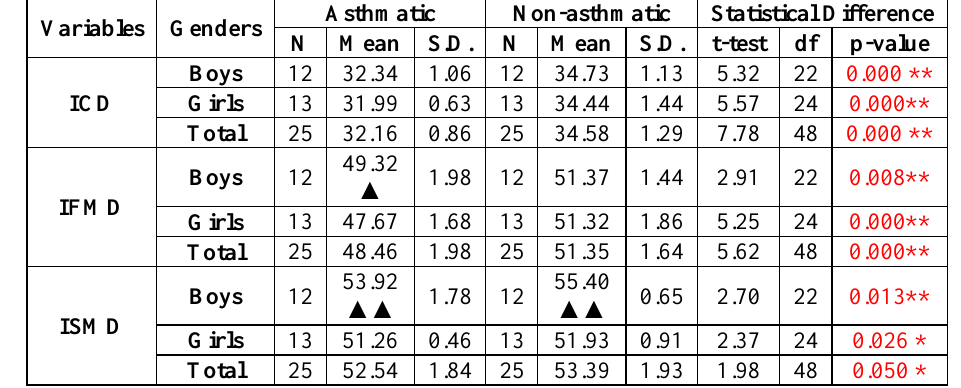
Table 1 Maxillary arch width (mm) among asthmatic and non-asthmatic children by genders.